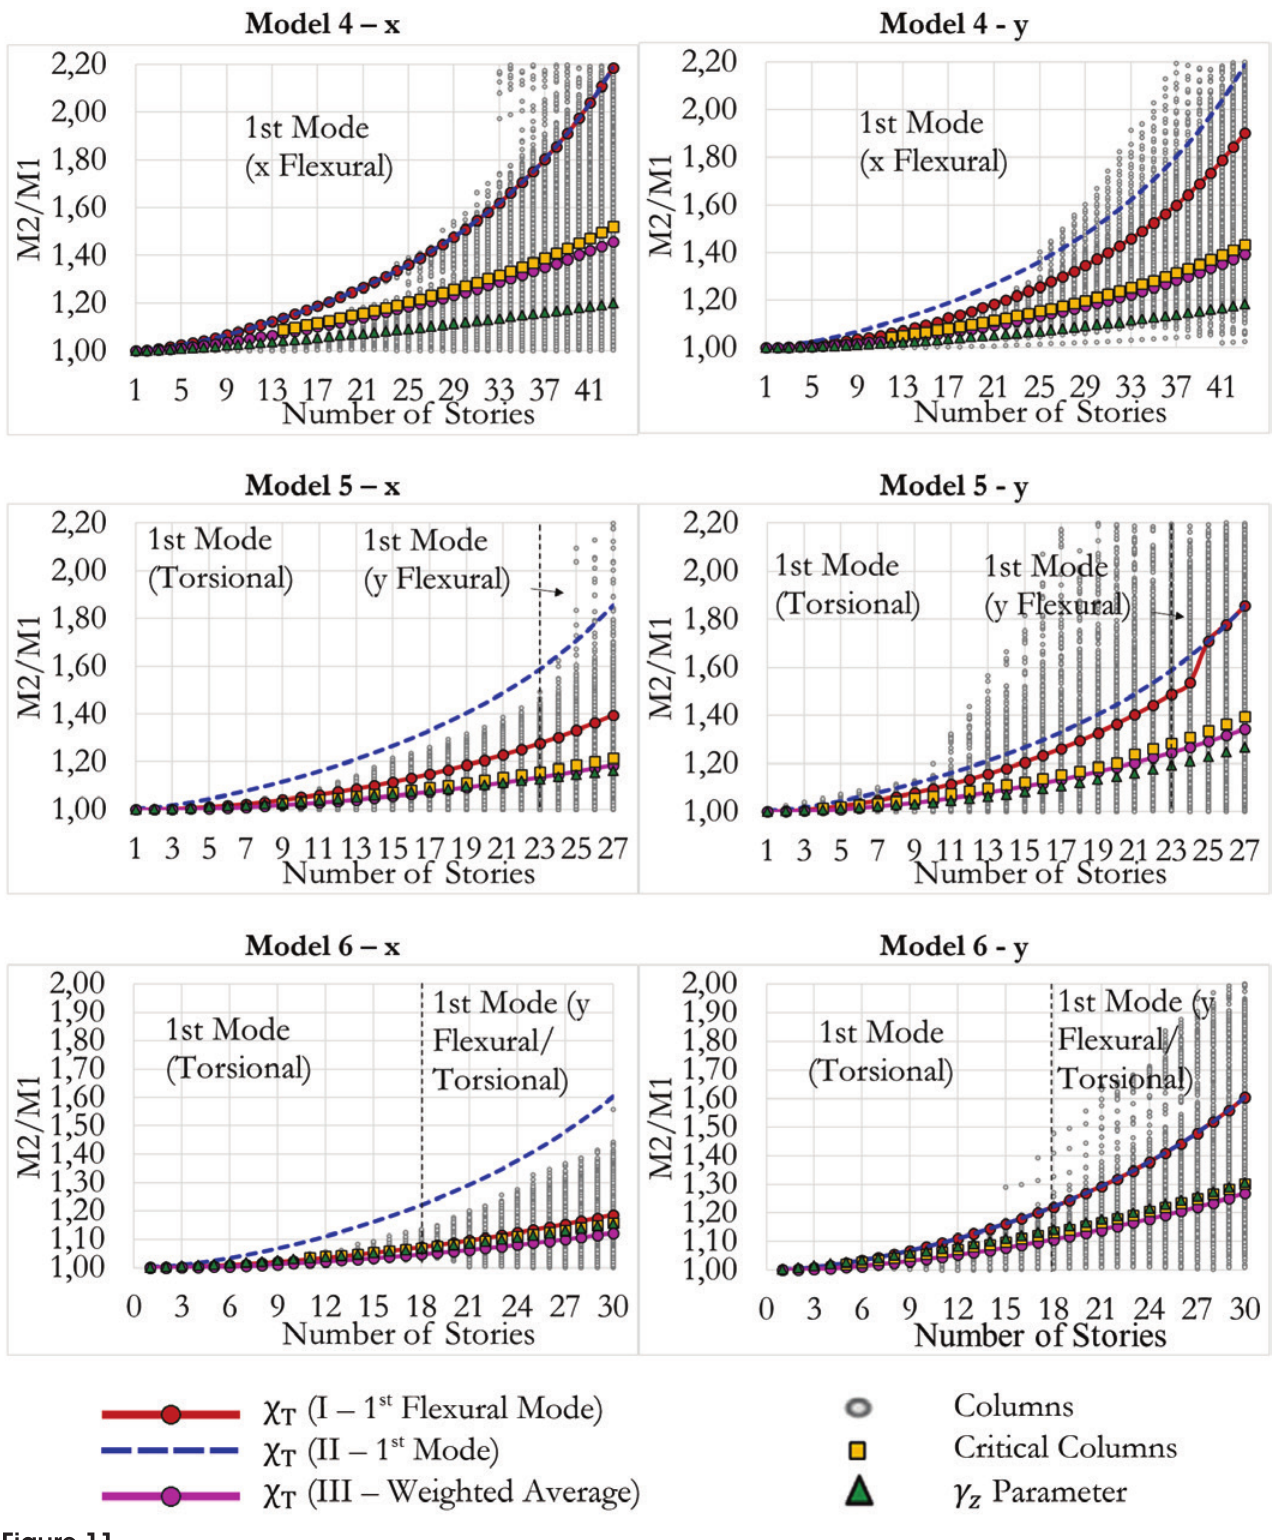
Moment amplification M Models 4, 5,